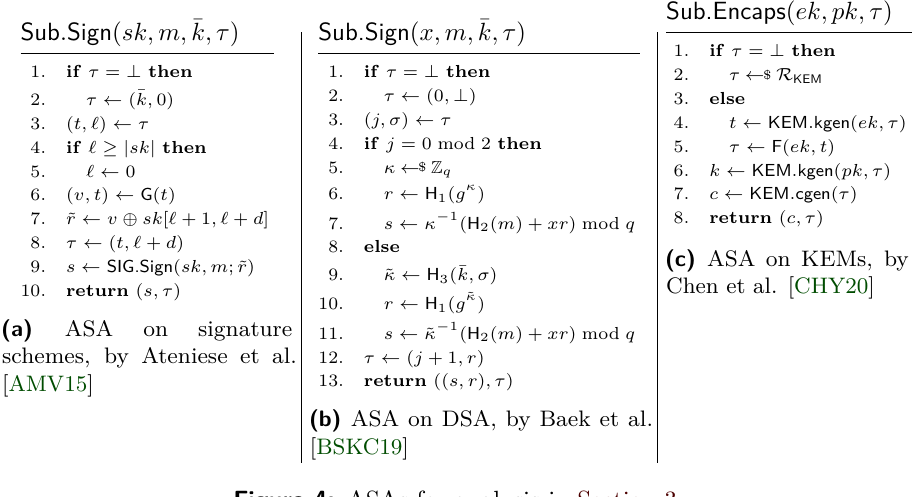
Figure 4: ASAs for analysis in Section